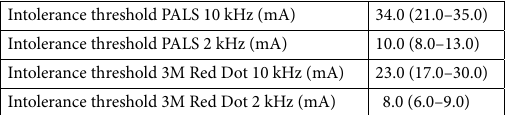
Intolerance threshold PALS 10 kHz